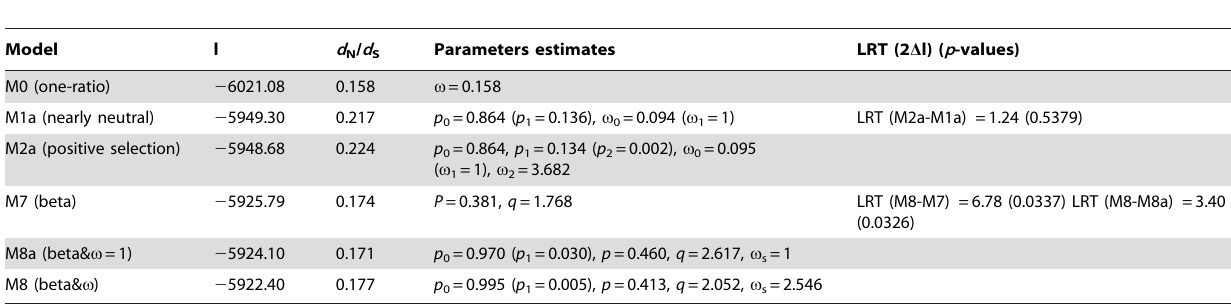
Table 7. The values of log-likelihood (l), d N / d S , and parameter estimates in CODEML analysis of swine A(H1N1) HAs between 1990– 2009.